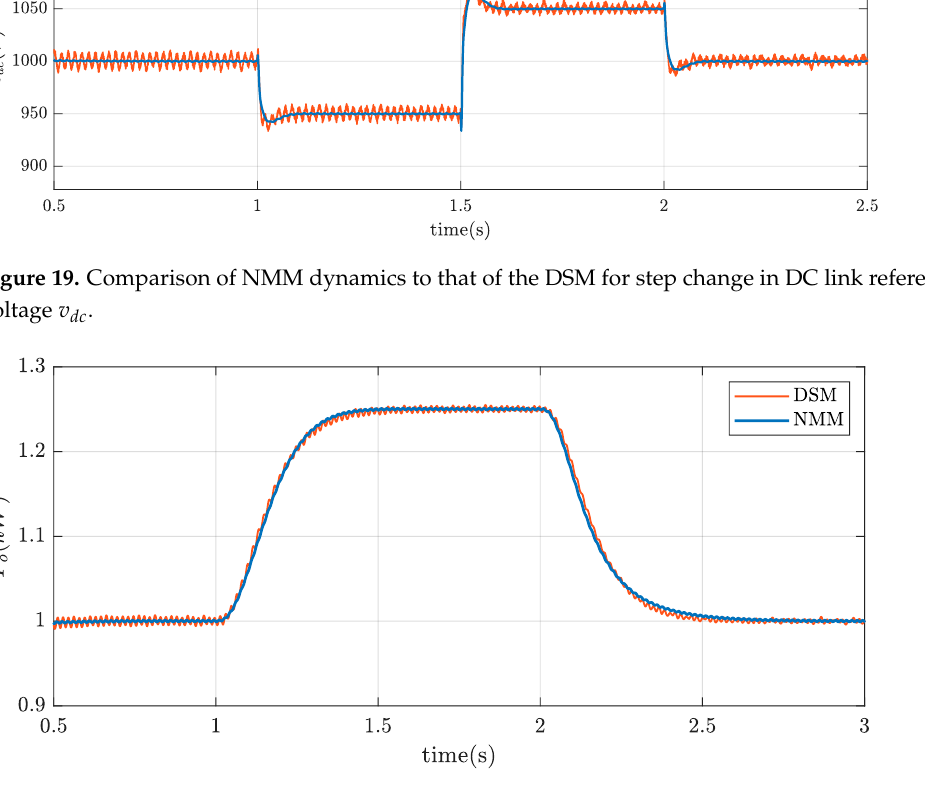
∗ . Figure 20. Comparison of NMM dynamics to that of the DSM for step change in P VSC . 𝑉𝑉𝑉𝑉𝑉𝑉∗ 𝑉𝑉𝑉𝑉𝑉𝑉∗ 𝑃𝑃 𝑃𝑃